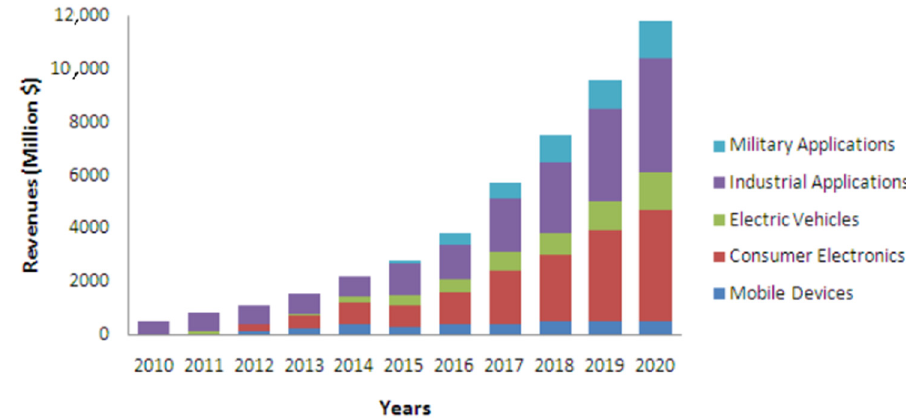
Figure 5. Predicted values of WPT technology in 2020 [62].